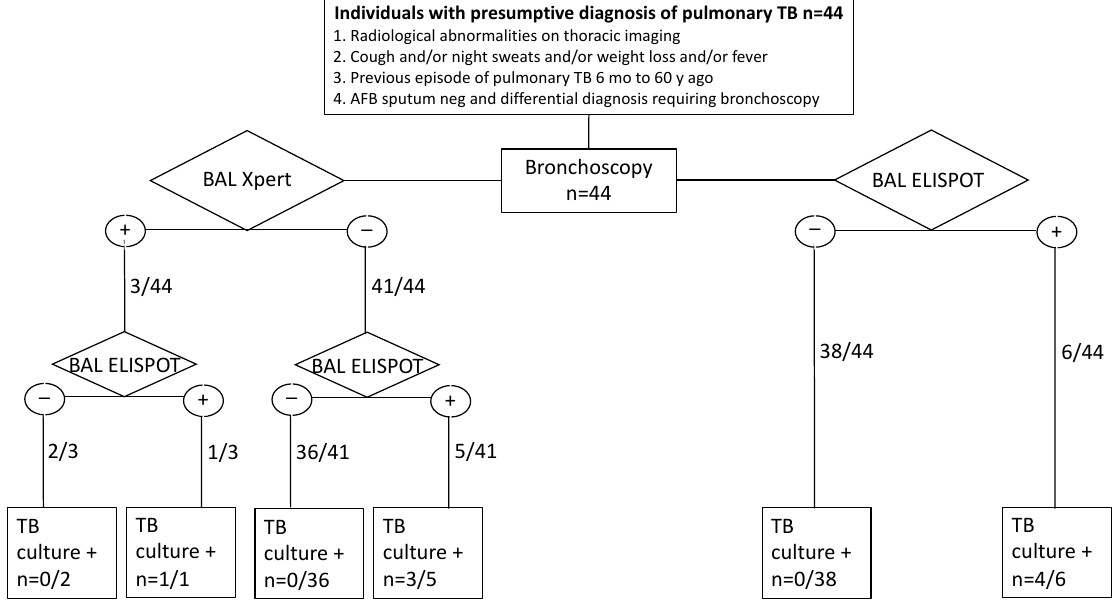
Figure 1 . Study flow diagram of individuals with a presumptive diagnosis of pulmonary tuberculosis (n=44). Patients with clinical signs of infection, radiological abnormalities on thoracic imaging, a previous episode of pulmonary tuberculosis, negative microscopy for AFB on sputum, and a differential diagnosis requiring bronchoscopy were tested for BAL Xpert, BAL Elispot, and TB culture results. AFB: acid-fast bacilli, BAL: bronchoalveolar